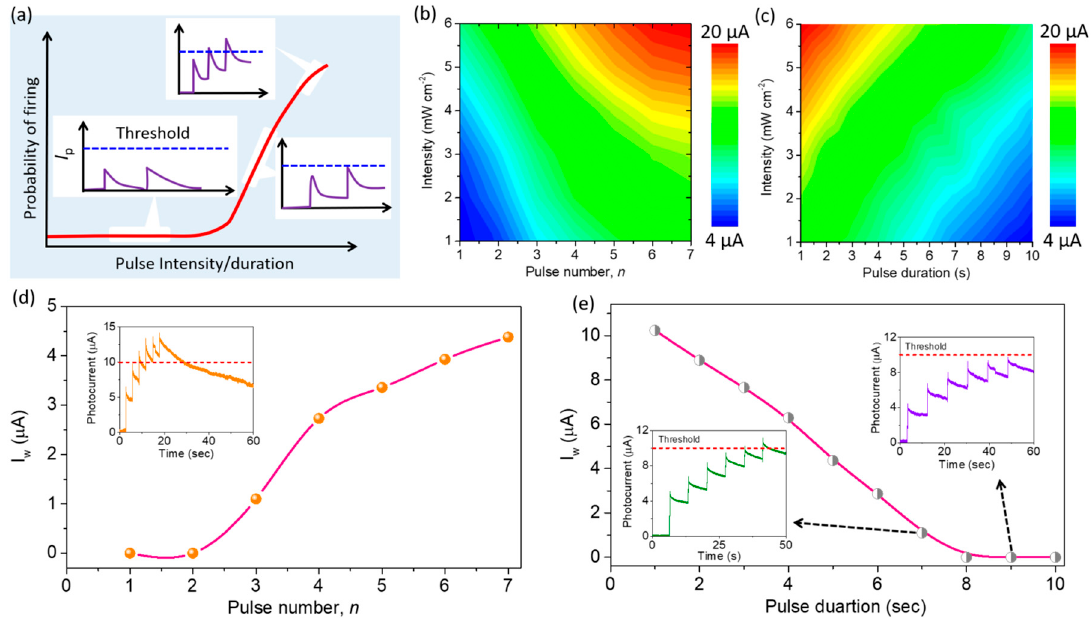
Figure 3. Mimic bio-neuron behavior. ( a ) Probability of firing as a function of pulse intensity or duration. The insets show the signal behavior for di ff erent pulse duration. ( b ) Three-dimensional (3D) map of the photocurrent with a function of pulse number and UV intensity; ( c ) 3D map of the photocurrent with a function of pulse duration and UV intensity. ( d ) Pulse number-dependent photocurrent generation above the threshold. ( e ) Current above the threshold as a function of pulse duration. ( e ) The inset shows photoresponse for a six number of pulses, showing a continuous increasing behavior with increasing number of pulses, the threshold property of the device is depicted by red dotted line.